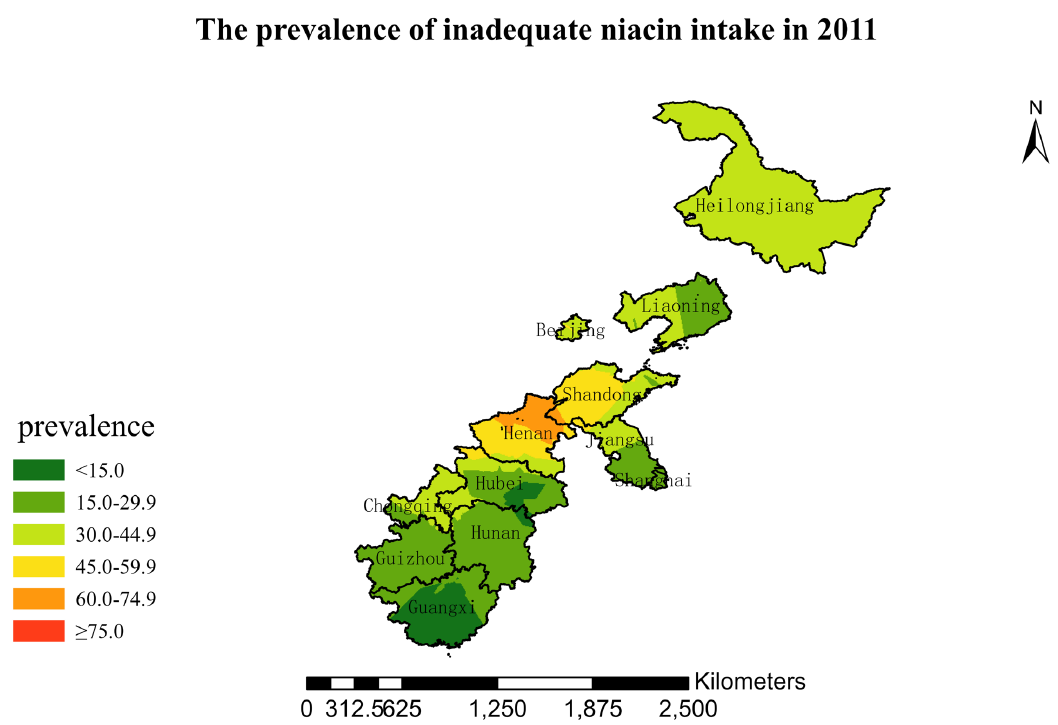
Figure 8. The prevalence of inadequate niacin intake by county in 2011 among Chinese Residents ≥ 5 Years of Age.